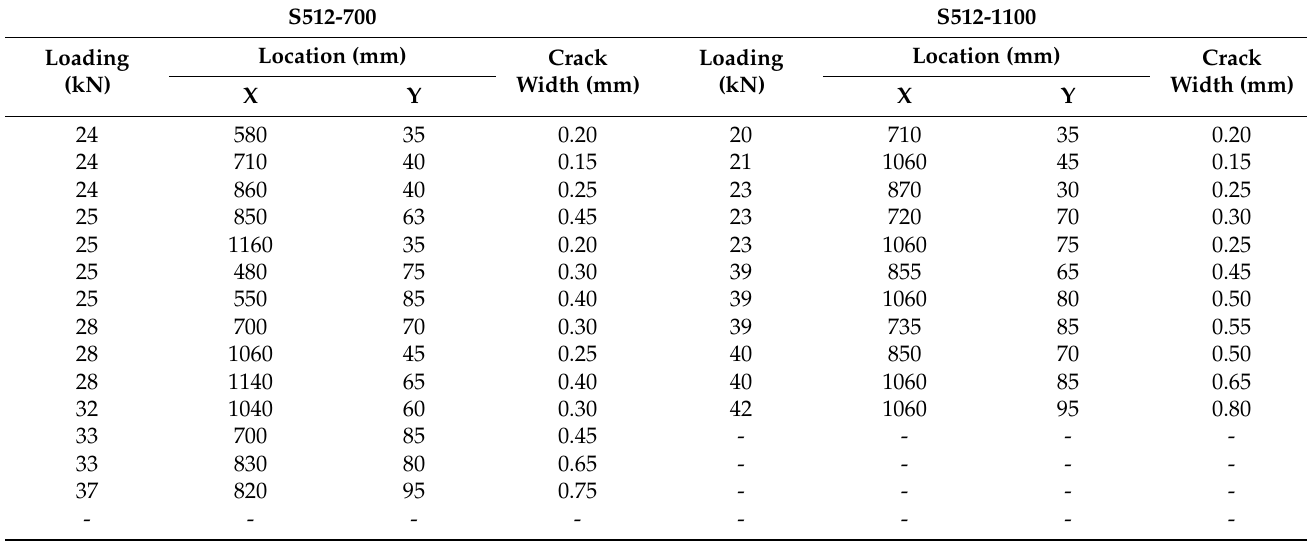
Table 9. Crack widths and their locations for the S512-1100 and S512-700 specimens.